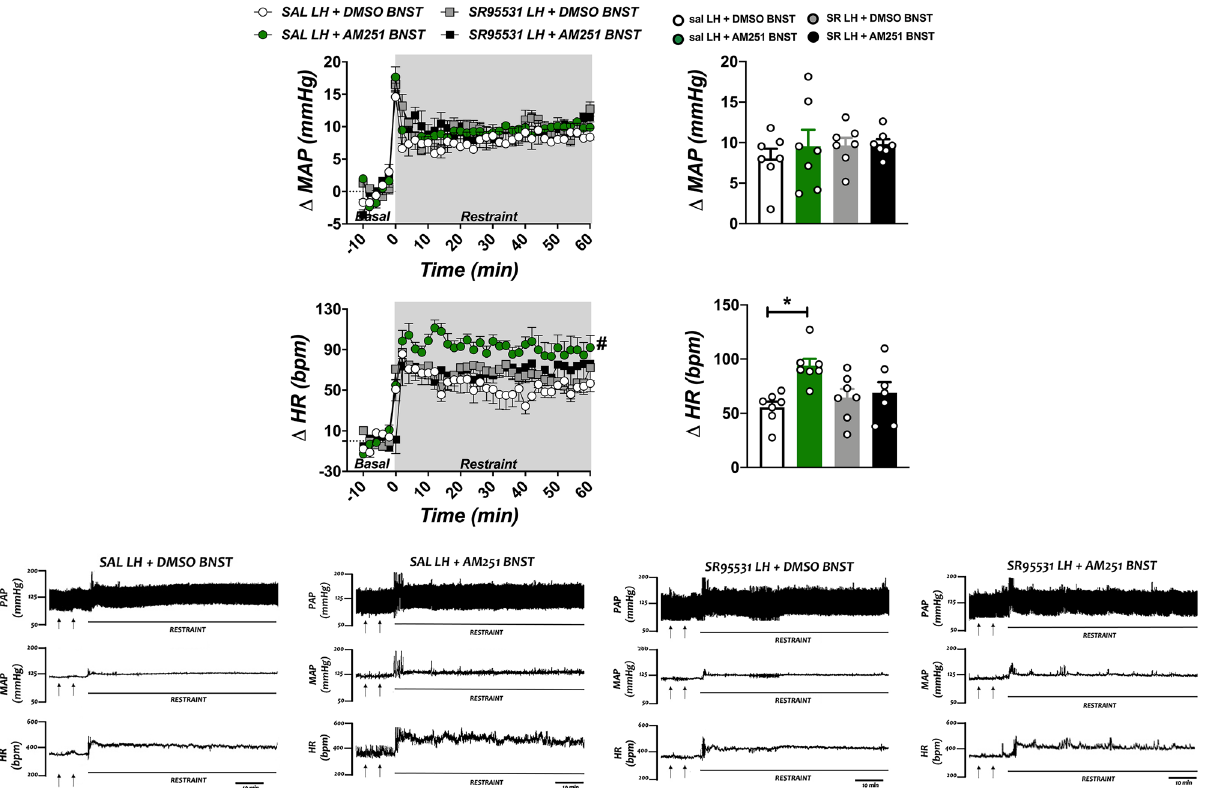
Figure 2. Effect of lateral hypothalamus (LH) treatment with the selective GABA A receptor antagonist SR95531 and/or microinjection of the CB 1 receptor antagonist AM251 into the bed nucleus of the stria terminalis (BNST) in arterial pressure and heart rate (HR) changes evoked by an acute session of restraint stress. (Top, left) Time-course curves of changes on mean arterial pressure (Δ MAP) and HR (Δ HR) evoked by acute restraint stress in animals treated bilaterally into the LH with saline (SAL, 100 nL) or the selective GABA A receptor antagonist SR95531 (1 pmol/100 nL), followed by a second microinjection into the BNST of vehicle [solution of saline containing 30% of DMSO (DMSO), 100 nL] or the selective CB 1 receptor antagonist AM251 (AM251, 100 pmol/100 nL). Circles represent the mean ± SEM. # P < 0.05 over the entire restraint period compared